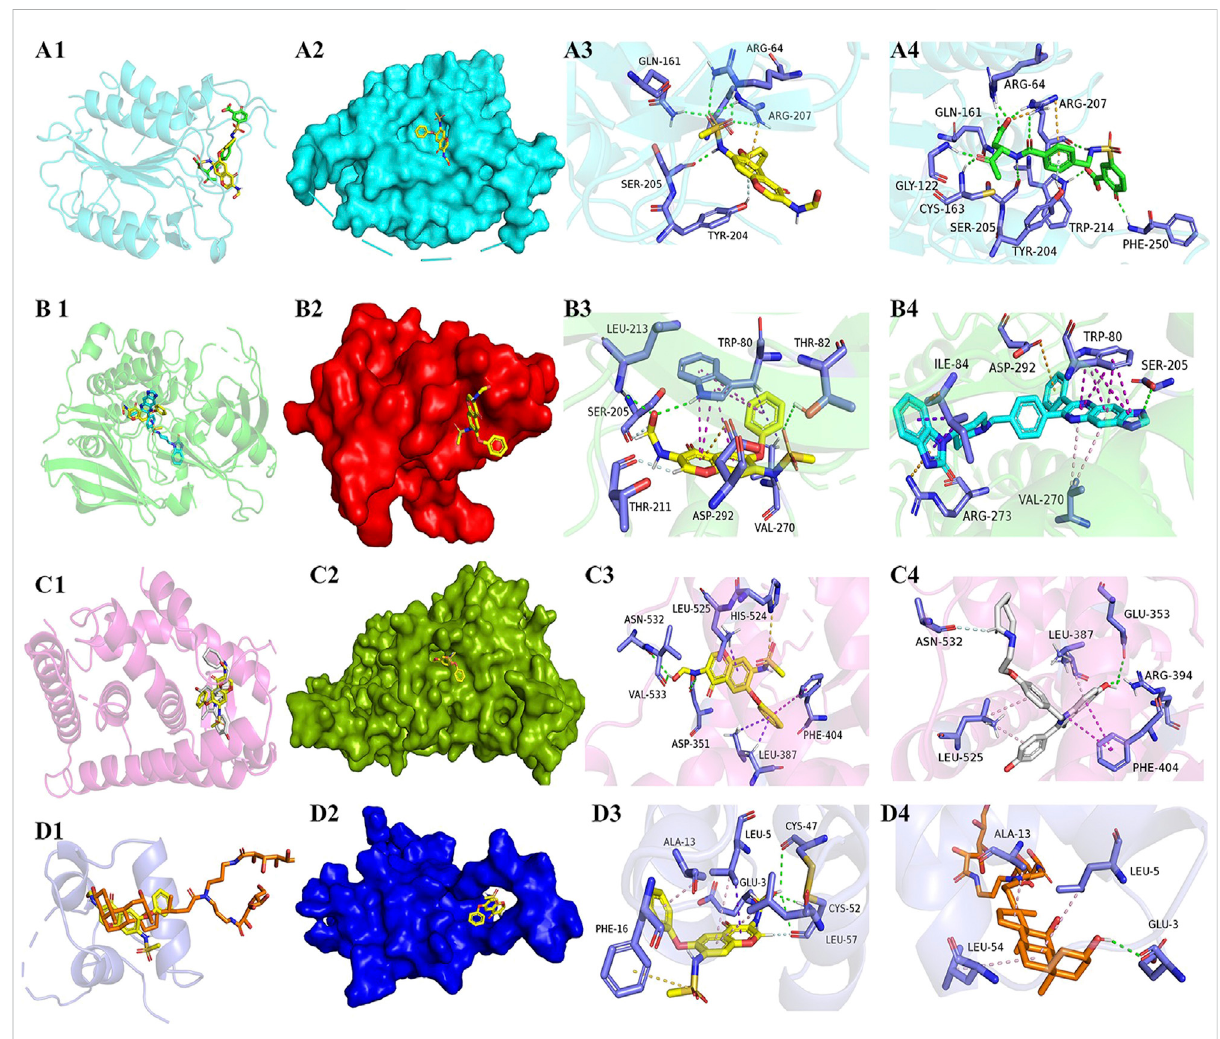
FIGURE 5 Diagrams of docking models of IGU and the four most related target molecules. 5 – 1. (A – D) Docking views of target proteins CASP3, AKT1, EGFR, and IGF1 with IGU , respectively. 5 – 2. 1, 2, 3, and 4 in each line indicates the description of the following, respectively: 1) Number 1 of each group is a cartoon comparison plot of the binding of IGU , inhibitor, and the target protein, with IGU as a yellow structure, and the four groups of inhibitors coloredgreen, lightblue,white, and orange, respectively. 2)Number2ofeachgroup isasurfacemodeling ofnumber 2,respectively. 3) Number 3 of each group is a concrete picture of the binding of IGU to the target protein, respectively. 4) Number 4 of each group is a concrete picture of inhibitor binding to the target protein, respectively. (A) CASP3 - IGU . (B) AKT1 - IGU . (C) EGFR - IGU . (D) IGF1 - IGU